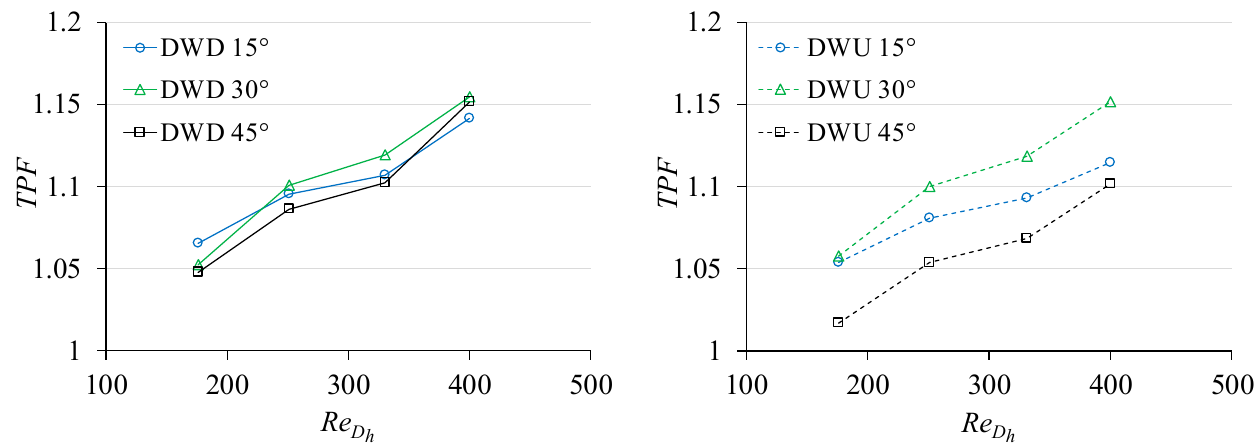
Figure 18. The effect of attack angle on TPF for air-to-water FTHEX with delta-winglet downstream (DWD, solid lines) and delta-winglet upstream (DWU, dashed lines) configurations. Test conditions: T air,in = 22 °C, T water,in = 40 °C, w water,in = 0.76 m/s.